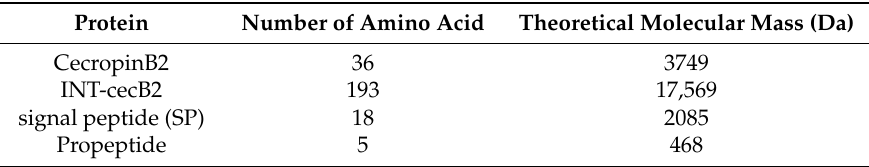
Table 3. Number of amino acid and theoretical molecular